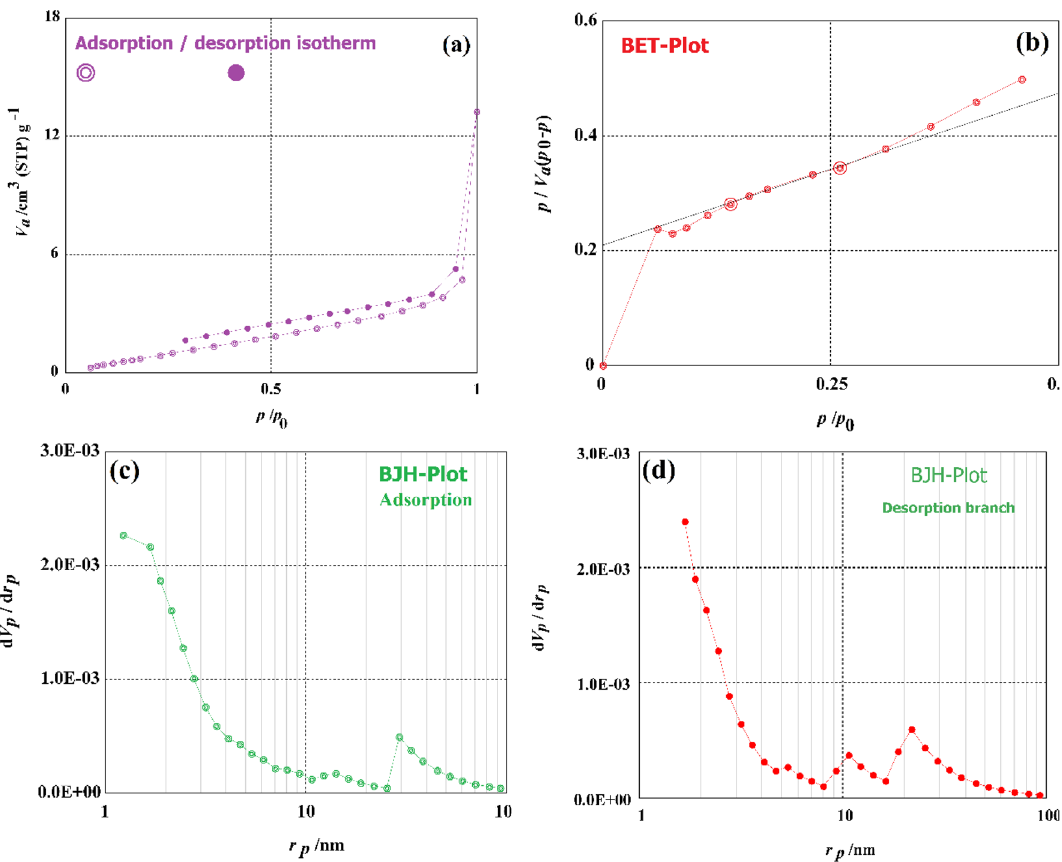
Figure 3. ( a ) Adsorption–desorption graph of MCT, ( b ) BET analysis graph of MCT, and ( c ) BJH adsorption analysis graph of MCT; ( d ) BJH desorption analysis graph of